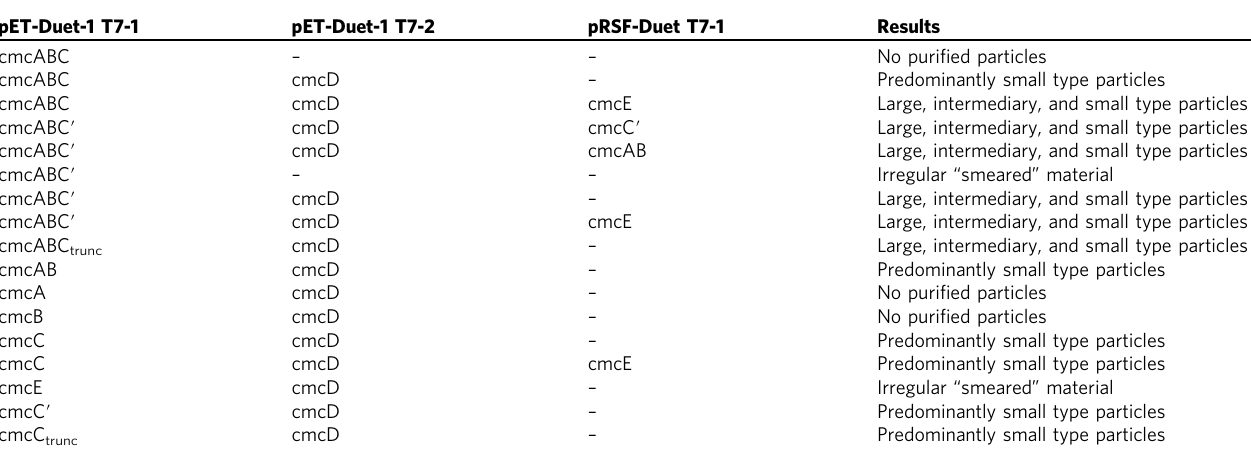
Table 1 Summary of BDP self-assembly experiments (Supplementary Figs. 1 – 3 and 12).